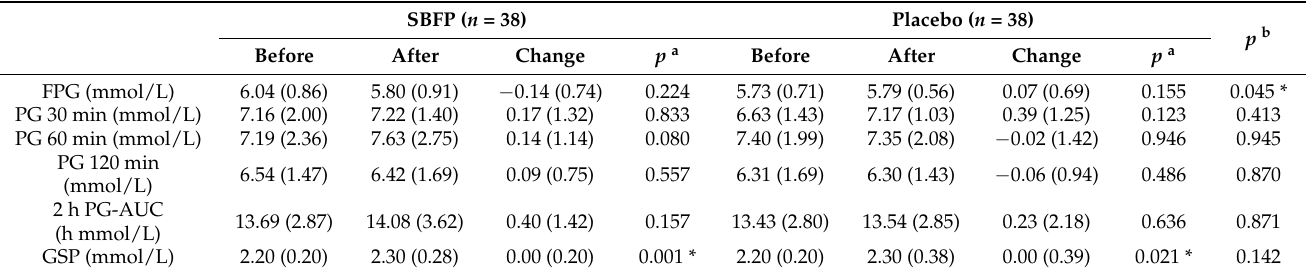
Table 5. Effects of SBFP and placebo on glycemic